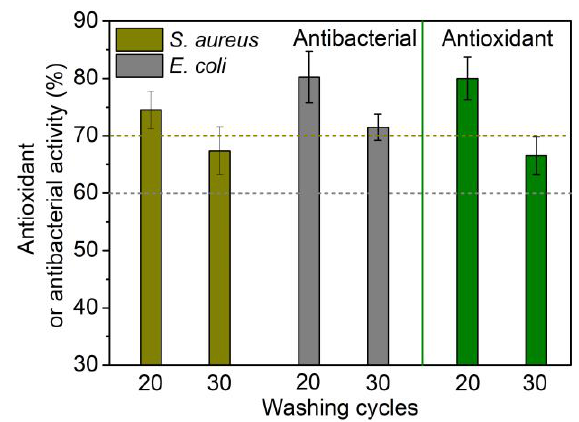
Figure 10. Antioxidant and antibacterial properties of polyamide fiber treated using 10% owf quercetin after 20 and 30 cycles of laundering.